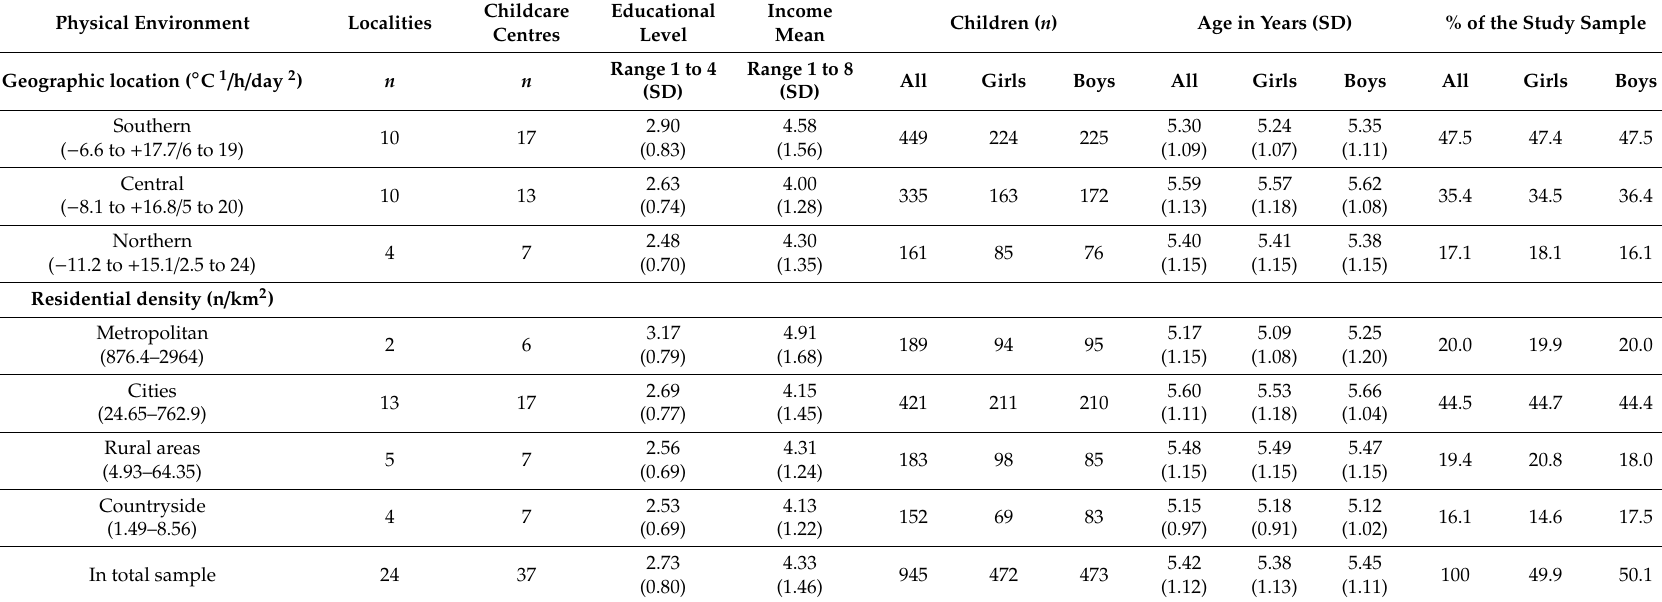
Table 1. Geographical location, residential density and characteristic of living environment of study